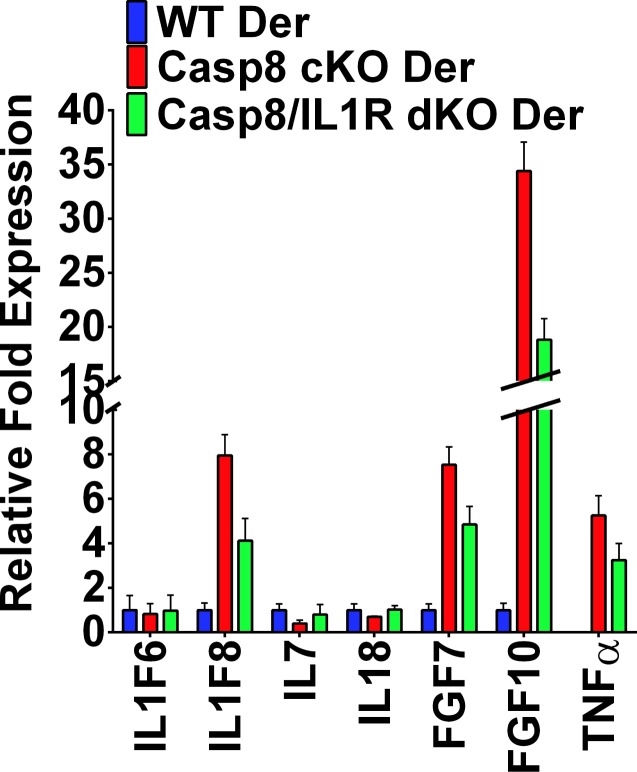
Expression of other IL-1 family members in the dermis.qPCR of P4 dermis from the different genotypes represented as the fold difference ± SEM. Data were collected from five mice per genotype.